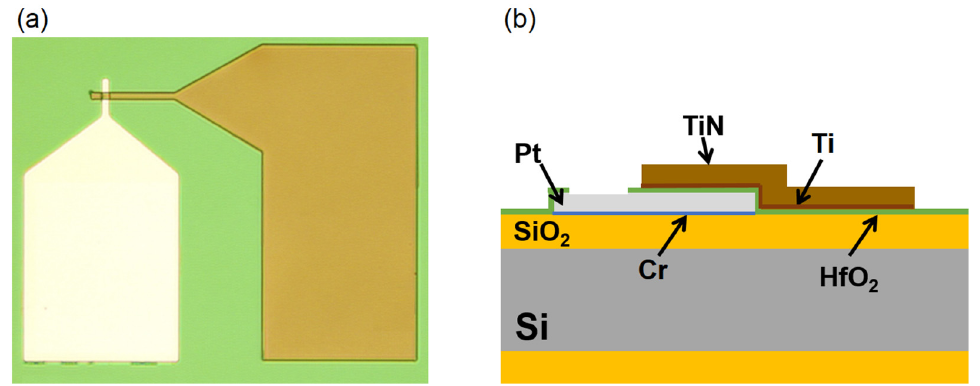
Figure 1. ( a ) Layout of the cross-point configuration. ( b ) Cross-section of the